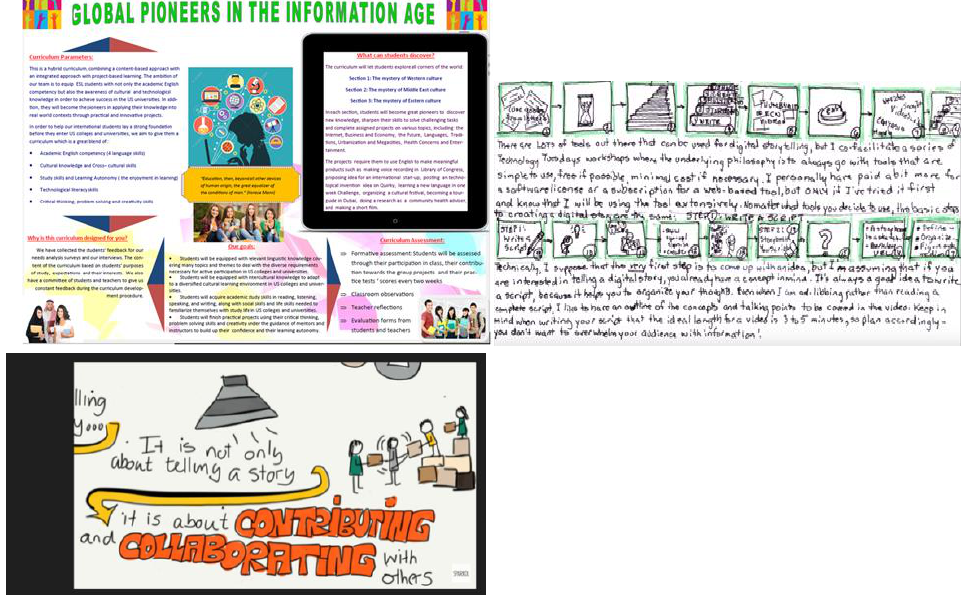
Figure 5. Samples of digital portfolio, comic strips, and digital storytelling, which are